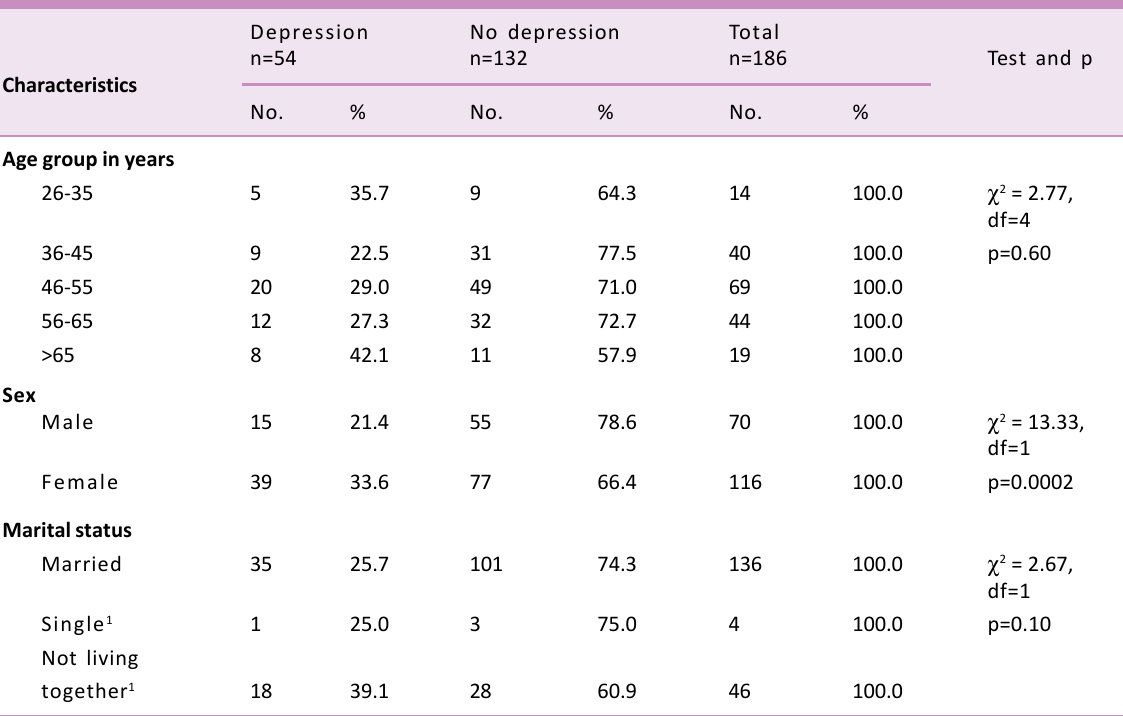
Table 2. Association between depressive disorder and personal characteristics